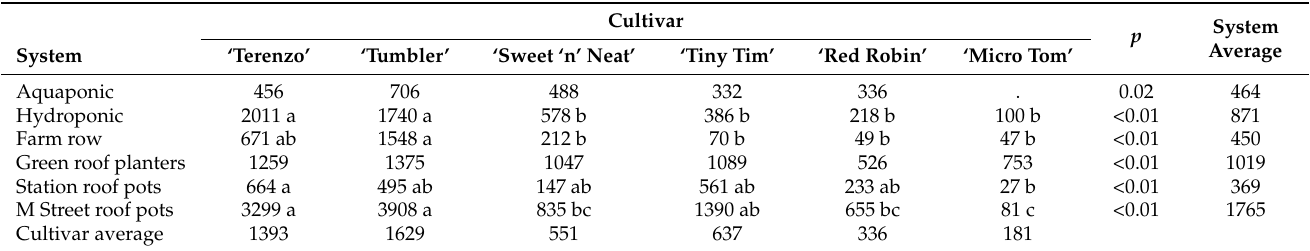
Table 1. Mean mass, in grams, of marketable cherry tomatoes per plant across six cultivars and six systems. Means with different letters within a row are different (Tukey–Kramer means separation test, p <